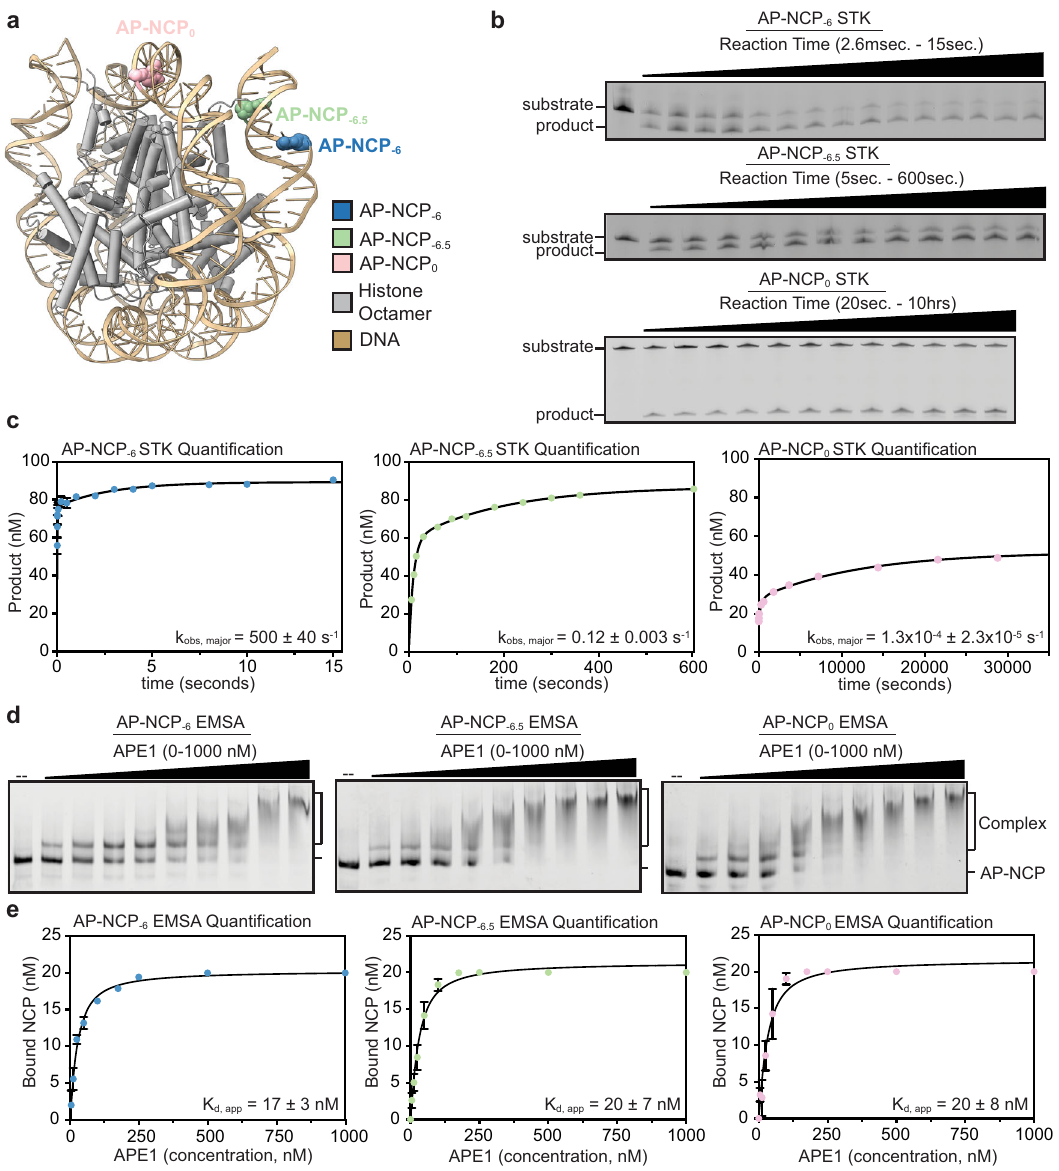
Fig. 1 | APE1 endonuclease activity is position-dependent in the nucleosome. a Structure of a nucleosome core particle (PDB:4JJN) with the AP site positions at SHL -6 , SHL -6.5 , and SHL 0 labeled. b Representative gels for APE1 single turnover kinetic (STK) experiments with substrate and product bands detected using the 6-FAM label. c Quanti fi cation with fi ts for the AP-NCP -6 , AP-NCP -6.5 , and AP-NCP 0 singleturnoverkinetic(STK)experiments.Thedatashownarethemean±standard errorofthemeanfromthreereplicateexperiments.Theerrorbarsareincludedbut